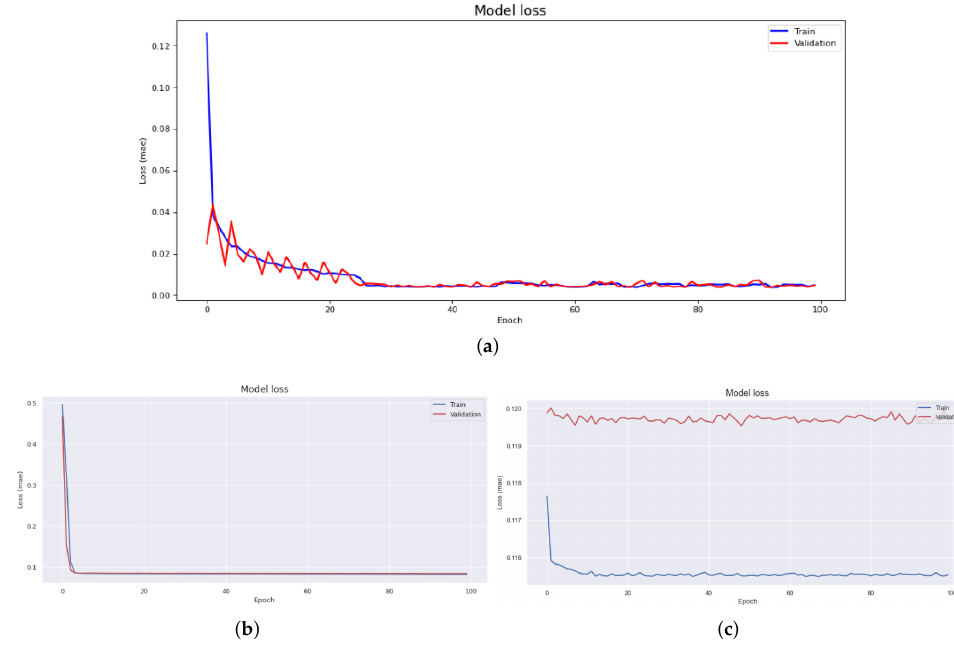
Figure 13. Loss graphs of results of using the Fourier transformed data, ( a ) result of using the convolutional auto-encoder, ( b ) result of using the auto-encoder LSTM, and ( c ) result of using the